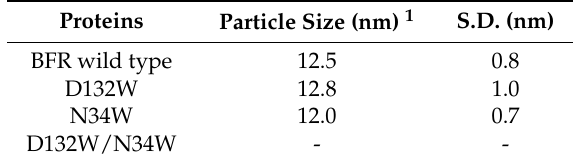
Figure 5. The role mutation plays in the thermal stability and folding reversibility of three mutants at the B-site interface. ( A ) CD spectra of the BFR derivatives before denaturation (solid line) and after slow cooling post-thermal denaturation (dashed lines); ( B ) Thermal transitions of the three mutants at B-site interface as monitored by CD at 222 nm. Data were collected at 1 °C intervals over a temperature range of 25 to 95 °C. The solid lines are the fit and the data points are the experimental data. Data is the average of at least three replicates.